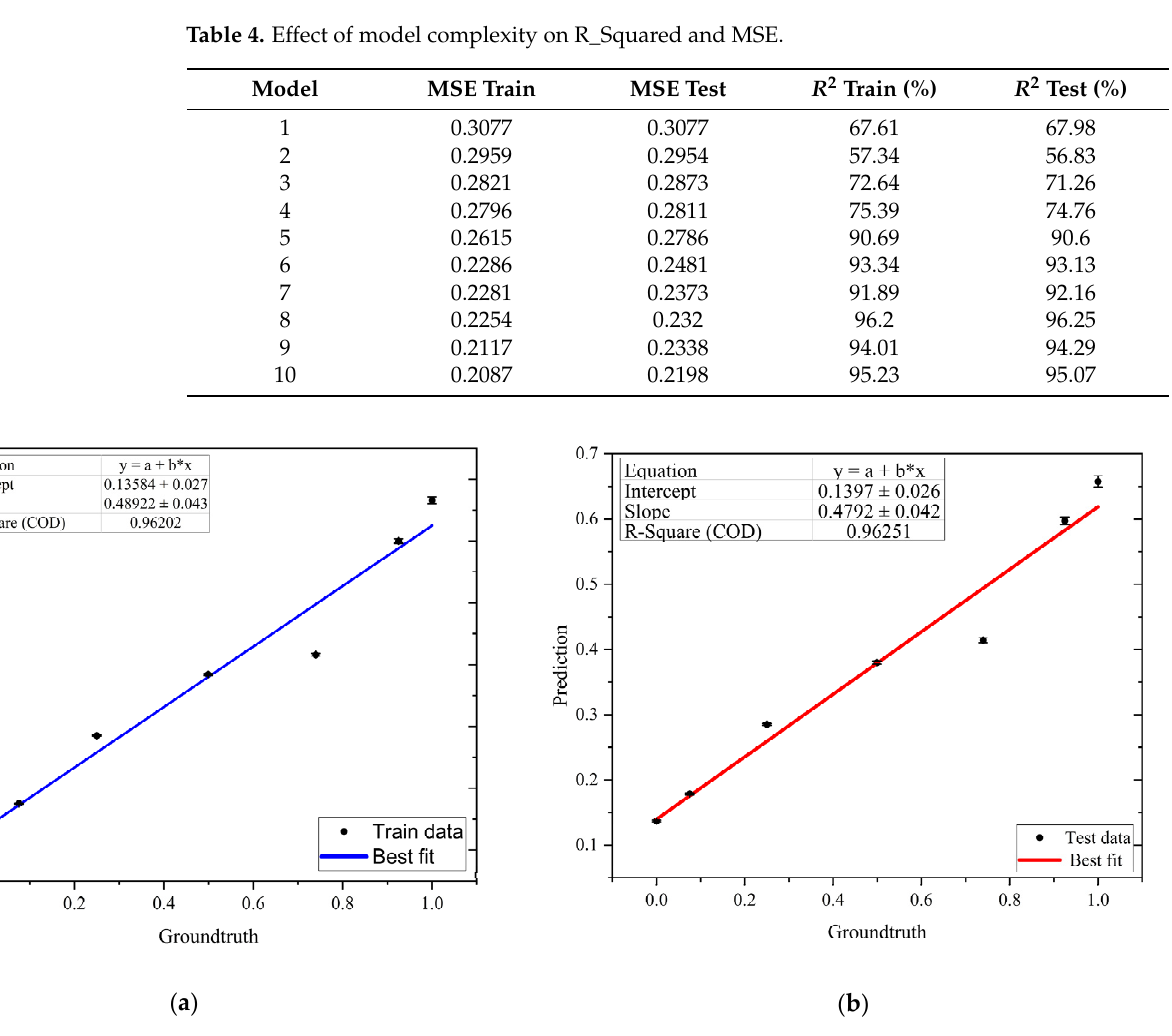
Figure 7. Results of representative regression model on ( a ) train and ( b ) test data. Table 4. Effect of model complexity on R_Squared and MSE.